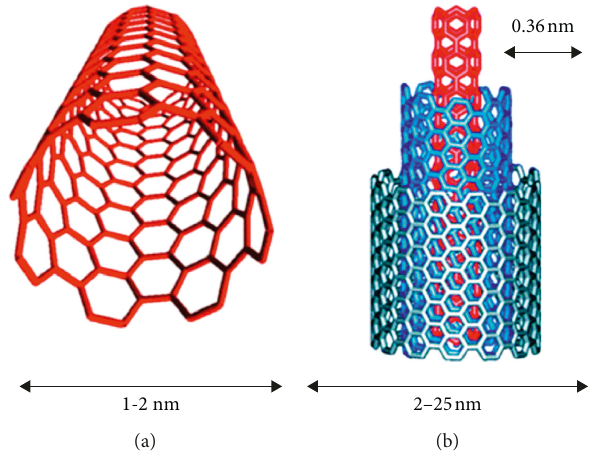
Figure 8: Schematic of (a) SWCNTs and (b) MWCNT